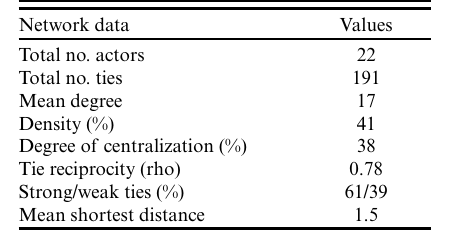
Table 2 . Network statistics